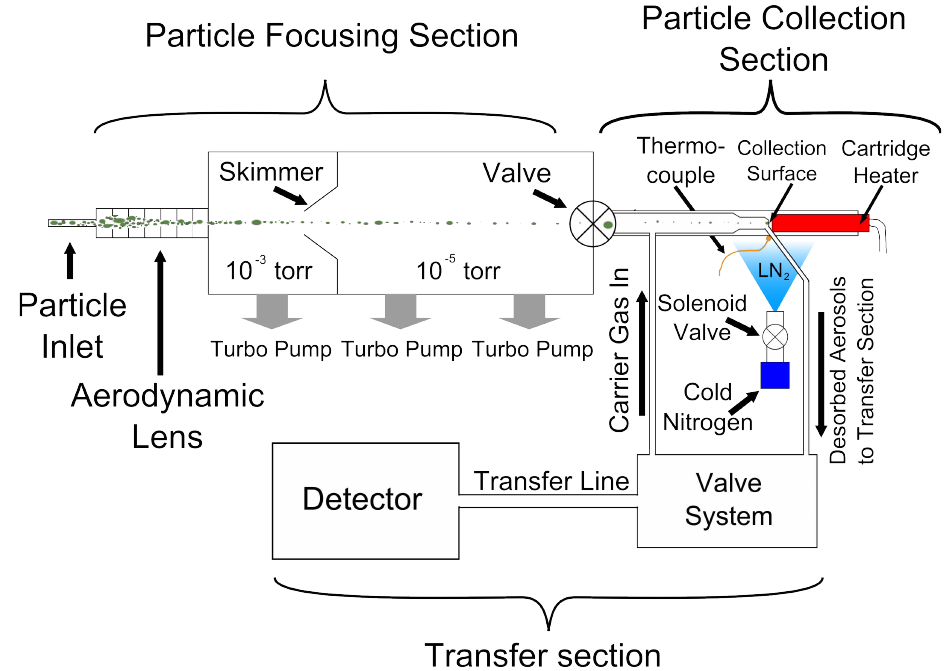
Fig. 1. Schematic of the ACM instrument. The ACM is composed of three main sections: the particle sampling section consisting of the aerodynamic lens and the vacuum system, the particle collection section including the collector and the cooling/heating system and the gasified particle transfer section which contains the valve system and the transfer